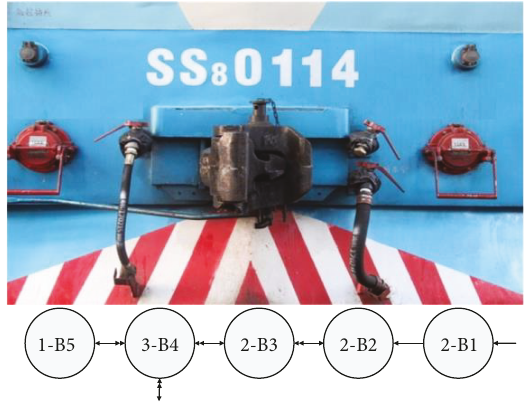
Figure 6: Model of brake gas